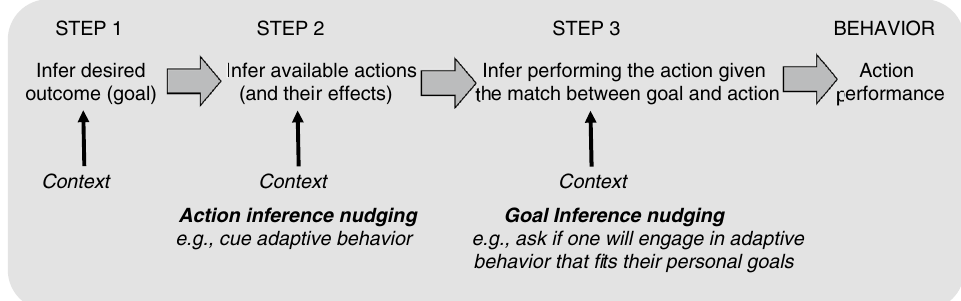
Figure 1. Illustration of the inferential process underlying behavior. Internal or external contextual influences first promote inference of a wanted outcome or goal. For instance, a person who sees other people in a store may infer that they would like to keep themselves and others safe from COVID-19. Next, an inference is made about the availability of certain actions and its expected effects. For instance, when seeing an alcohol dispenser with a sign to disinfect hands, a person may infer that they can disinfect their hands to adhere with COVID-19 guidelines. Step 3 involves the inference of performing a certain action given the match between expected action effects and current goals. For instance, a person may infer that they will disinfect their hands given the match with their goal to keep themselves and others safe from COVID-19. The latter inference may (automatically) translate into action performance (e.g., hand disinfection). Contextual influences moderate each of the inference steps. Action inference nudging interventions specifically target Step 2 whereas goal inference nudging interventions target Step